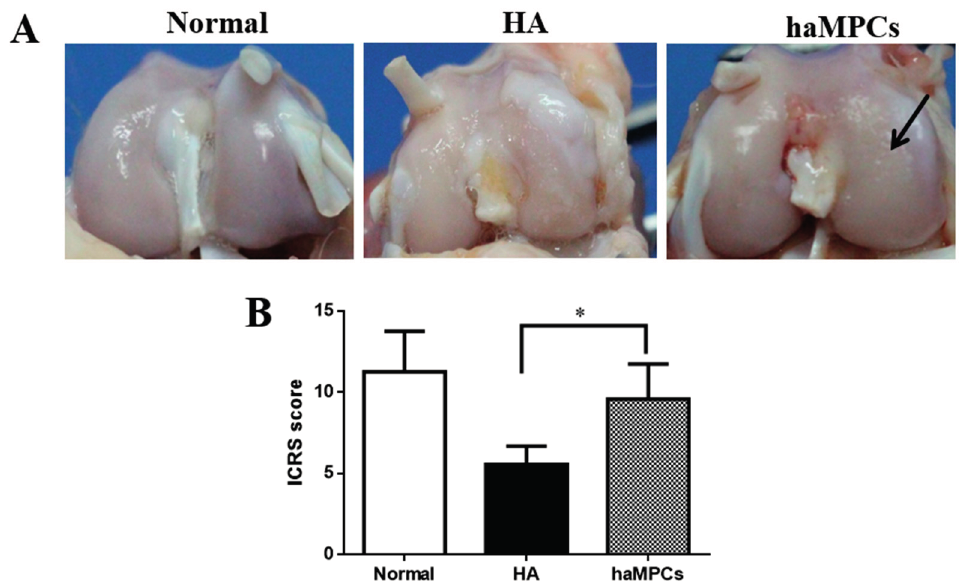
Figure 3. Macroscopic findings. ( A ) Sixteen weeks after surgery, in haMPC treatment group, eroded cartilage was almost completely covered by the repaired tissues (black arrow); and ( B ) Macroscopic OA ICRS scores showed haMPC treatment significantly increased ICRS scores compared with hyaluronic acid (HA) group. * indicates p <